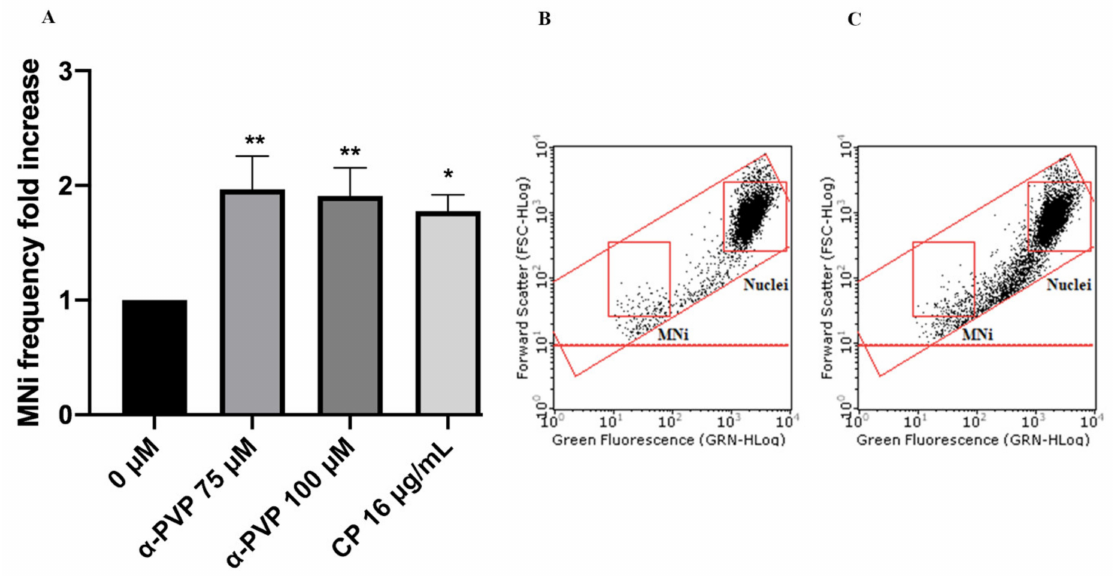
Figure 7. MNi frequency fold increase on TK6 cells after 3 h + S9 mix treatment with α -PVP at the indicated concentrations compared to the negative control [0 µ M] and to the positive control [CP] ( A ), plot of nuclei and MNi in the negative control ( B ) and in 100 µ M α -PVP-treated cultures ( C ). Each bar represents the mean ± SEM of five independent experiments. Data were analyzed using repeated ANOVA followed by Bonferroni post-test. * p < 0.05 vs. 0 µ M; ** p < 0.01 vs. 0 µ